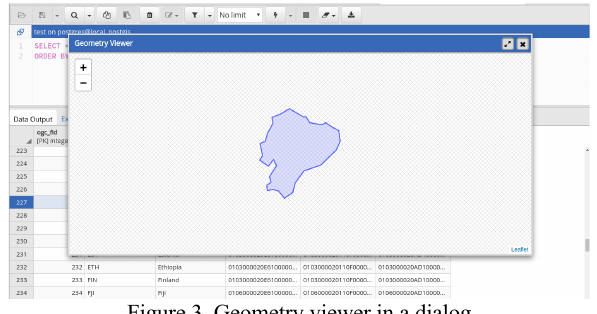
Figure 3. Geometry viewer in a